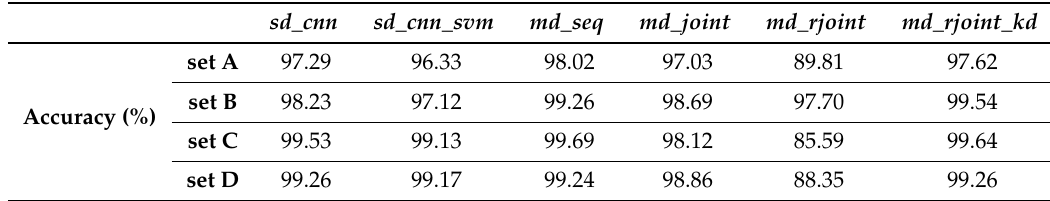
Table 2. Performance of all